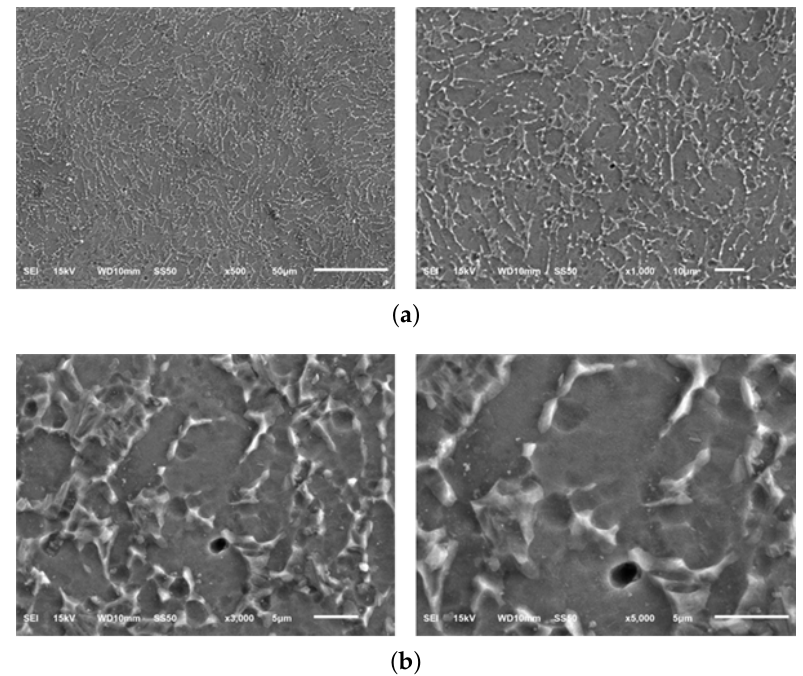
Figure 14. Microstructure of Material sample B—Scanning Electron microscopy (SEM). ( a ) Material sample B (500 and 1000 × ); ( b ) Material sample B (3000 and 5000 × ).